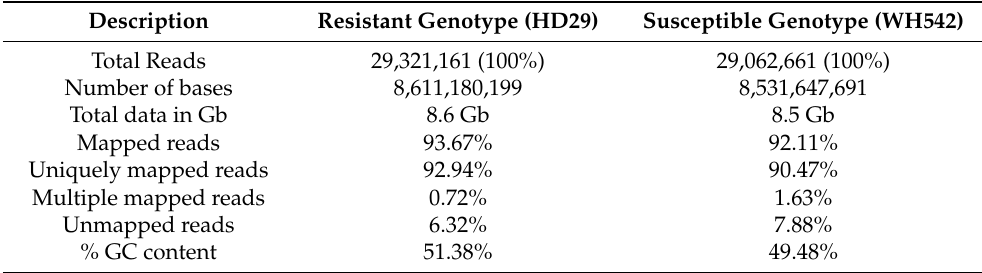
Table 1. Summary statistics of reads generated in RNA-Seq analysis of resistant and susceptible genotypes of wheat upon T . indica